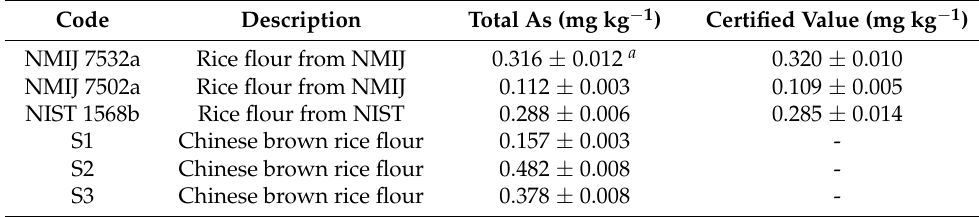
Table 3. Total arsenic in the certified reference materials and rice flour samples determined by ICP-MS after